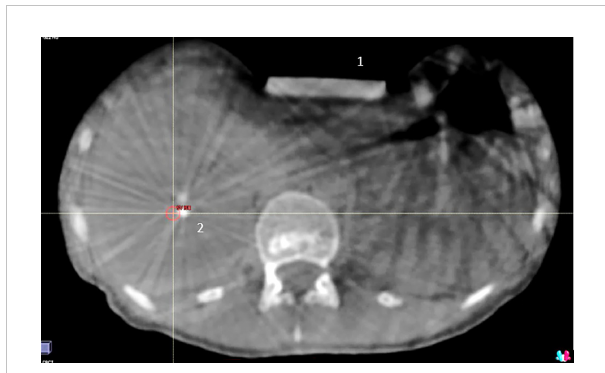
FIGURE 2 1: compression system; 2: fi ducials markers generating artifacts; tumor is not visible due to both poor image resolution and fi ducial markers artifacts.